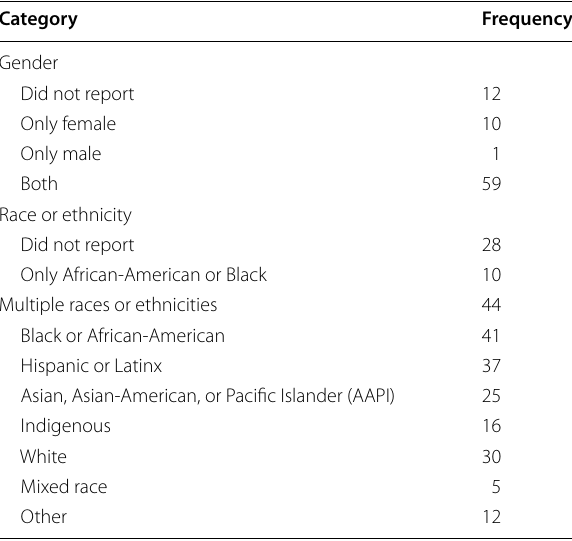
Table 2 Gender and race or ethnicity in articles in the